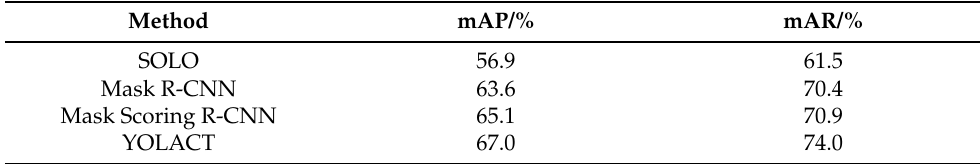
Table 3. Comparison of instance segmentation